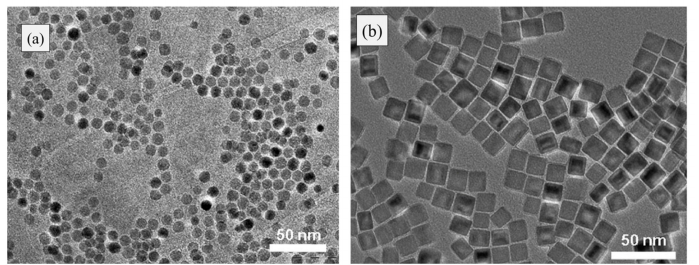
Figure 4. TEM micrographs: ( a ) spherical shaped and ( b ) cubical shaped. Obtained permission from Ref. [55]. Copyright 2011 American Chemical society.